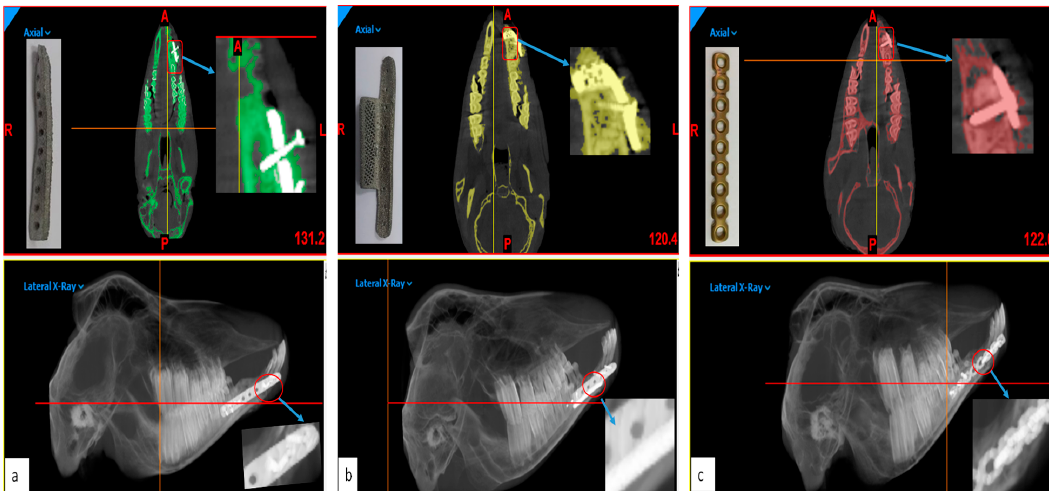
Figure 14. The healed segmental defects of three different goats with ( a ) reconstruction plate without mesh, ( b ) reconstruction plate with mesh and ( c ) synthesis commercial plate after 3 months post-surgery (arrows indicating the titanium plates filling the defects).